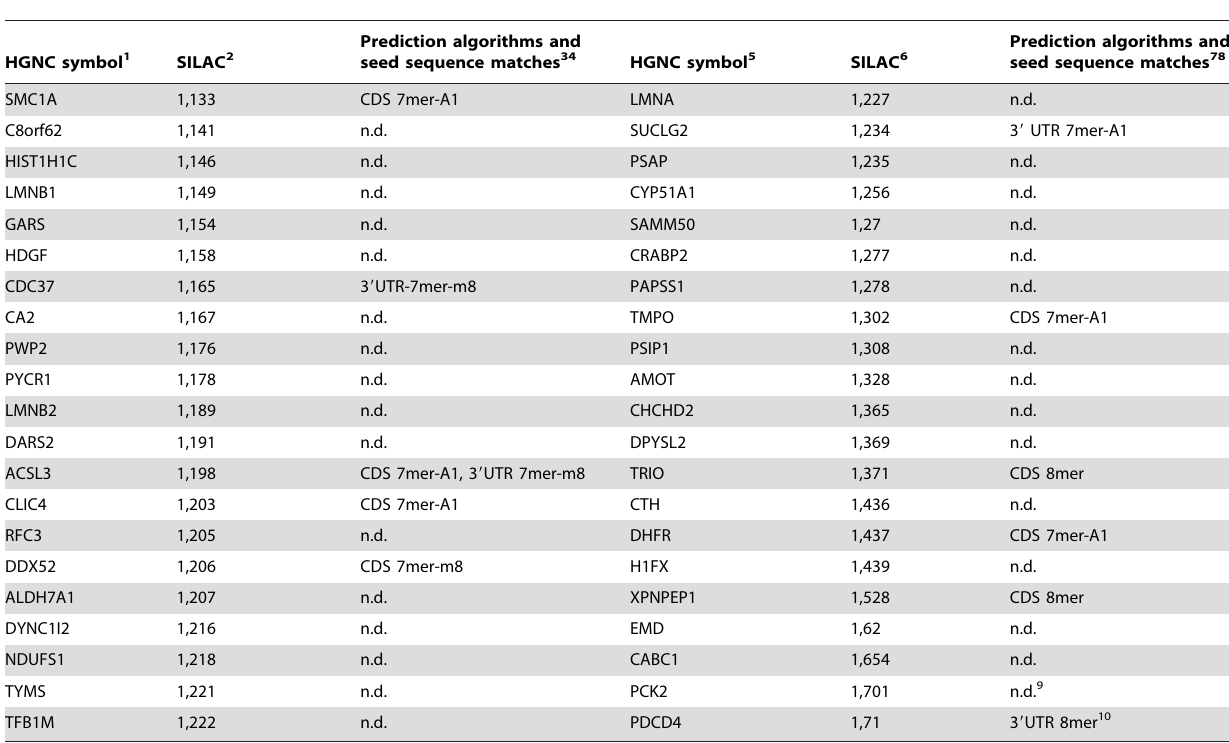
Table 3. Potential upregulated miR-155 target proteins in HEK293T cells detected by SILAC with prediction algorithms and seed sequence matches.